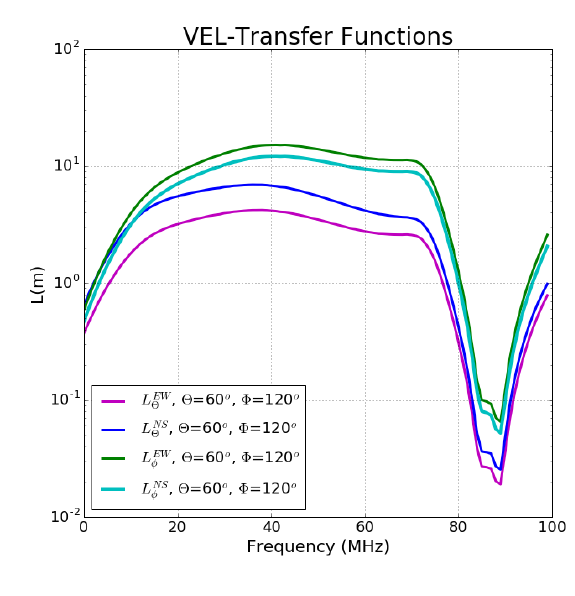
Figure 5. Butterfly Antenna VEL 30-80 MHz for EW / NS poles and for direction θ = 60 o , φ = 120 o .